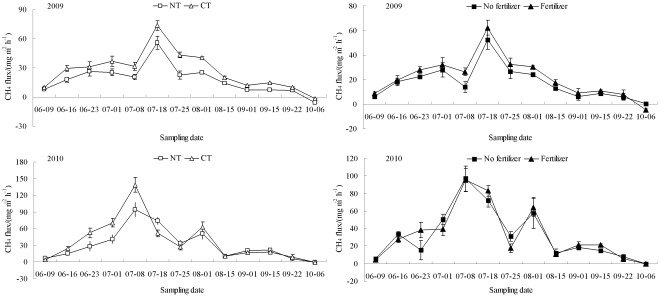
Changes in CH4 emission fluxes from paddy fields under different management practices during the 2009 and 2010 rice growing seasons.The vertical bars are standard deviations of the mean, n = 3.